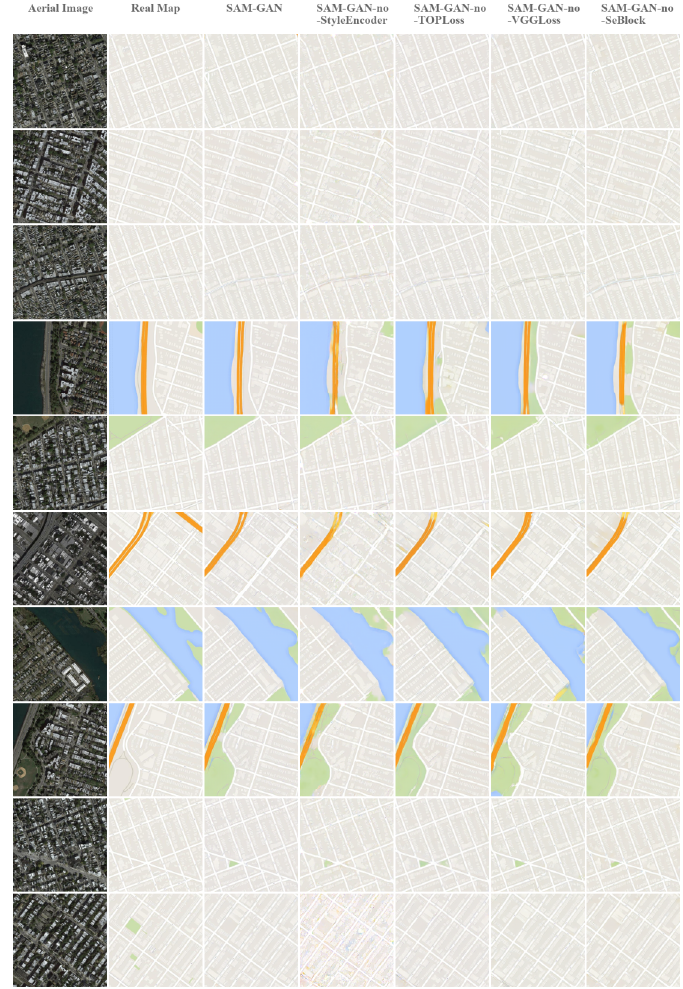
Figure 6. Qualitative comparison between aerial imagery and the map transformation model SAM- GAN in terms of ablation experiments. From left to right: aerial images, real maps, results of SAM-GAN, results of SAM-GAN-no-StyleEncoder, results of SAM-GAN-no-TOPLoss, results of SAM-GAN-no-VGGLoss, and results of SAM-GAN-no-SeBlock. In summary, the primary role of the style encoder is to improve the image quality by learning the underlying coding space, while the VGG and topological losses are mainly used to improve the accuracy of feature boundary lines and the accuracy of the model for rendering feature colors in the generated maps, thus increasing the structural correlation between the generated maps and the real maps and also improving the visual performance of the generated results. The attention mechanism used in SAM-GAN enhances the learning ability of the model during the training process and accelerates the convergence of the model. Combining the qualitative and quantitative results shows that SAM-GAN generates high-quality maps while also enhancing the visual aspects of the images. SAM-GAN provides better visual translation results from aerial images than SAM- GAN-no-StyleEncoder, SAM-GAN-no-VGGLoss, SAM-GAN-no-TOPLoss, and SAM-GAN- no-SeBlock, especially in terms of the edge detail of buildings in the image, completeness of roads, features, the rendering of corresponding colors, etc. This suggests that using the style encoder, the content loss, and the attention mechanism proposed in this paper can improve the model’s ability to capture image